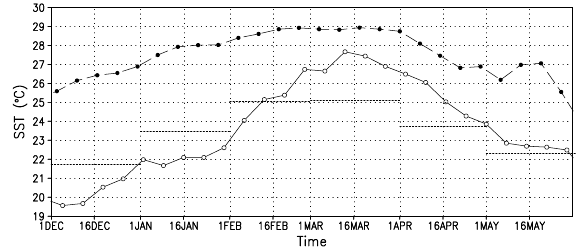
Fig. 2. Weekly sea surface temperature ( ◦ C) at 6.5 ◦ S, 82.5 ◦ W in 1997–1998 (dashed), 2001–2002 (solid) and 1970–2000 climatol- ogy (dotted). (Source: NCEP OI SST